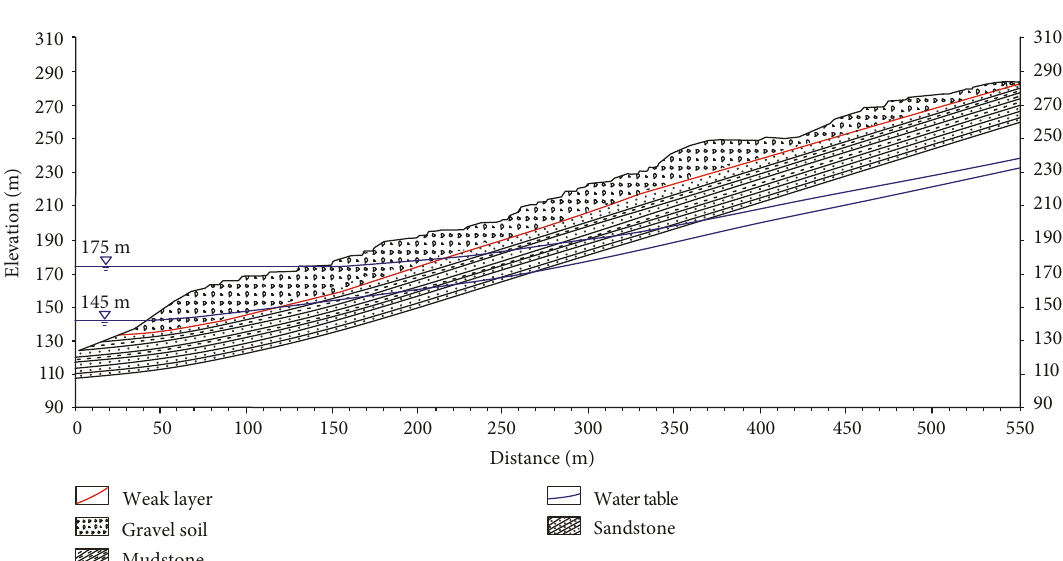
Figure 3: Vertical pro fi le along the Majiagou